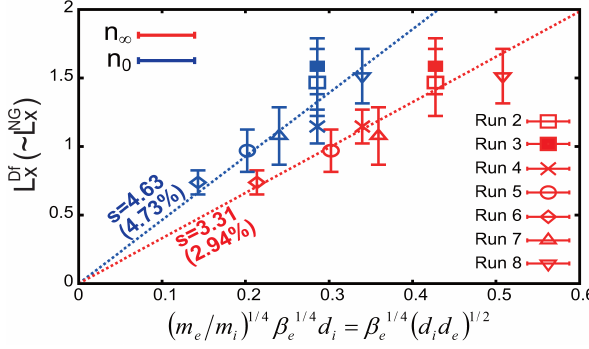
Figure 9. L Df x ( ∼ L NG x ) versus (m e /m i ) 1 / 4 β 1 / 4 e d i normalized by d i0 for Runs 2–8. n ∞ (red), and n 0 (blue) are examined to calculate d e and d i . Each value is the averaged one during a quasi-steady period. Error bars show the standard deviation, and the dashed lines indicates the regression lines with slopes and standard